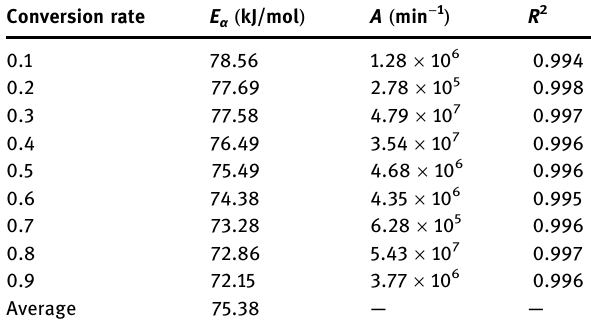
Table 5: Combustion kinetic parameters of sample